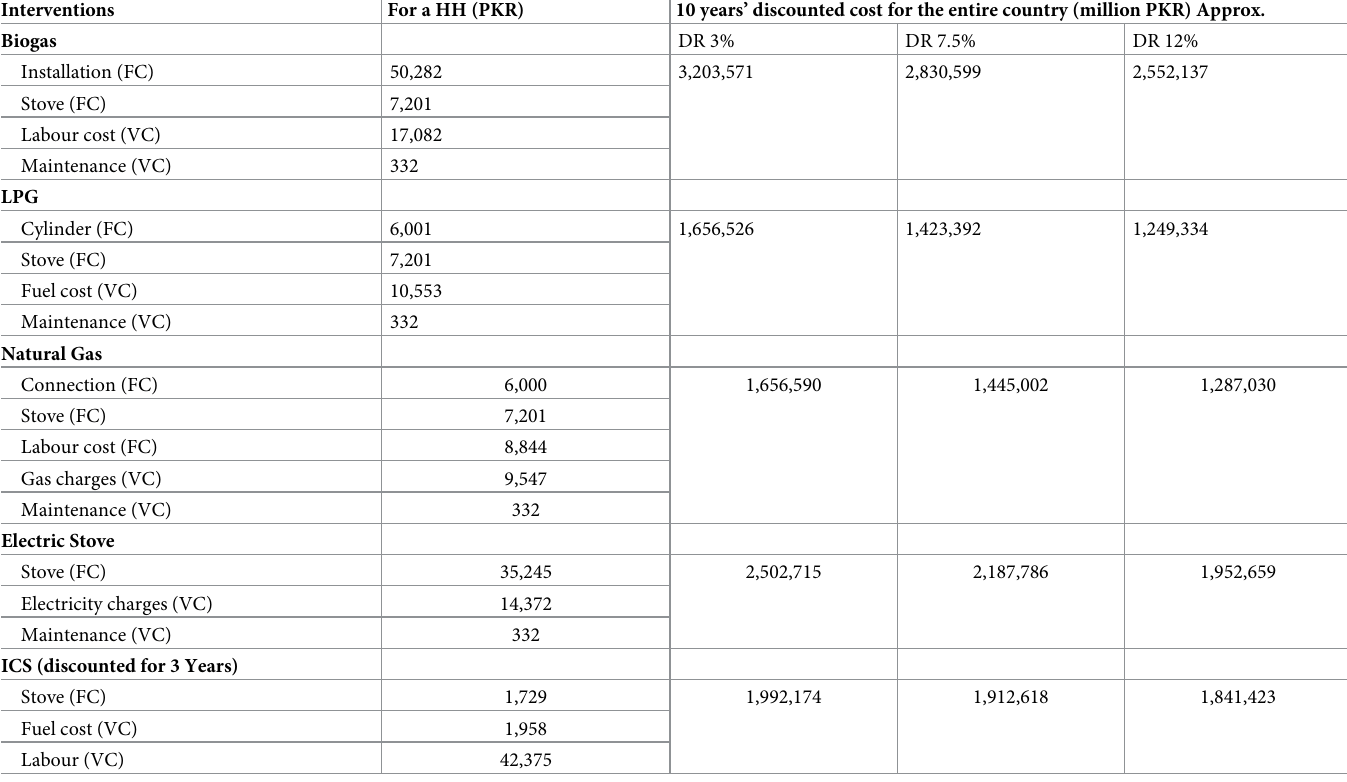
Table 2. Summary of the costs for all